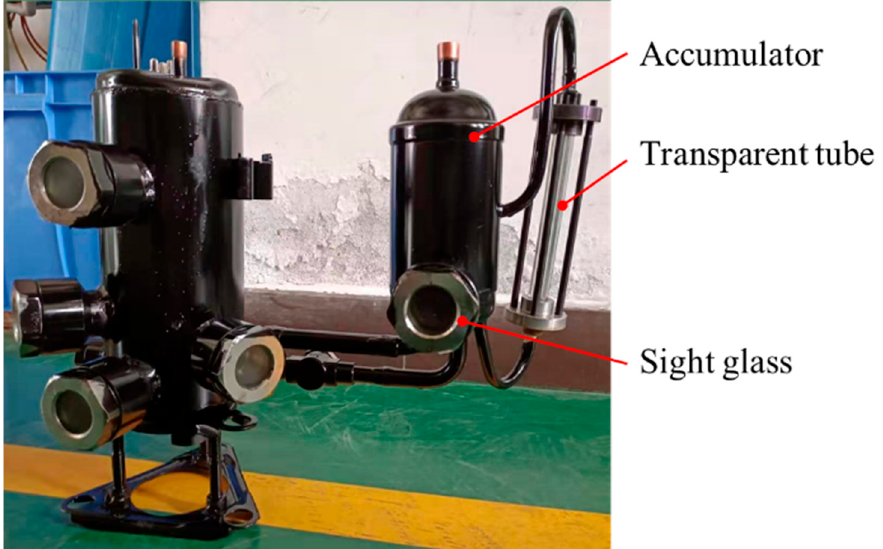
Figure 6. Test rotary compressor.